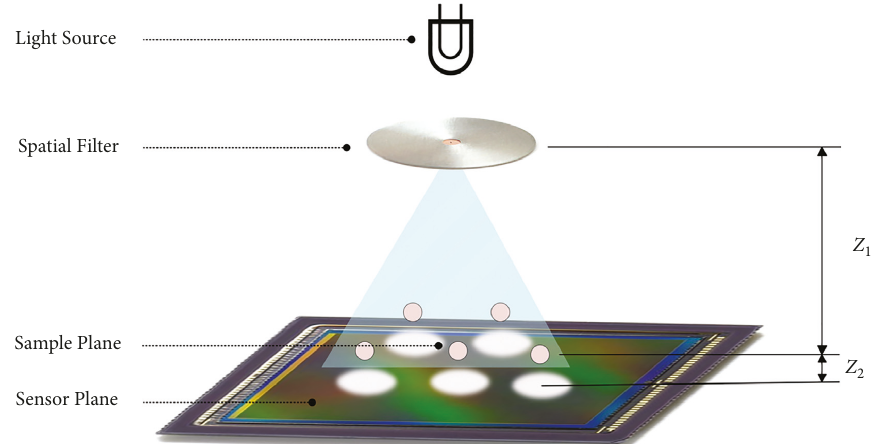
Figure 1: Schematic representation of the DIHM system, z